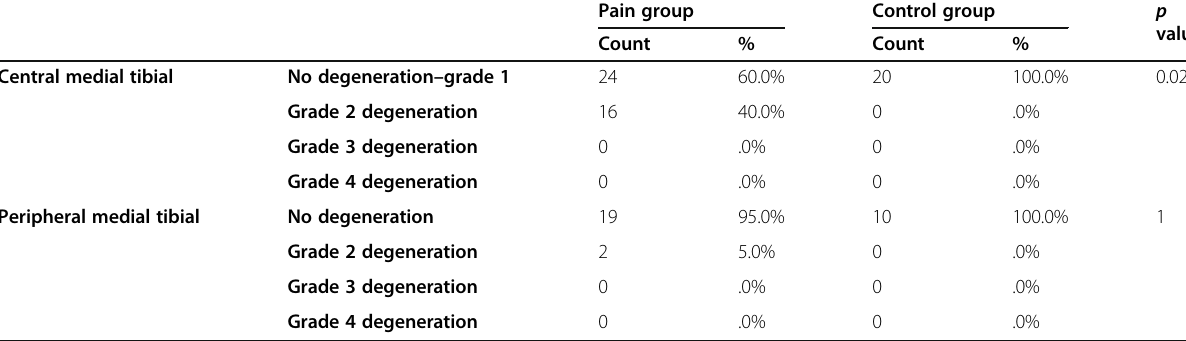
Table 5 Distribution of central and peripheral medial tibial degeneration according to ICRS degeneration grades